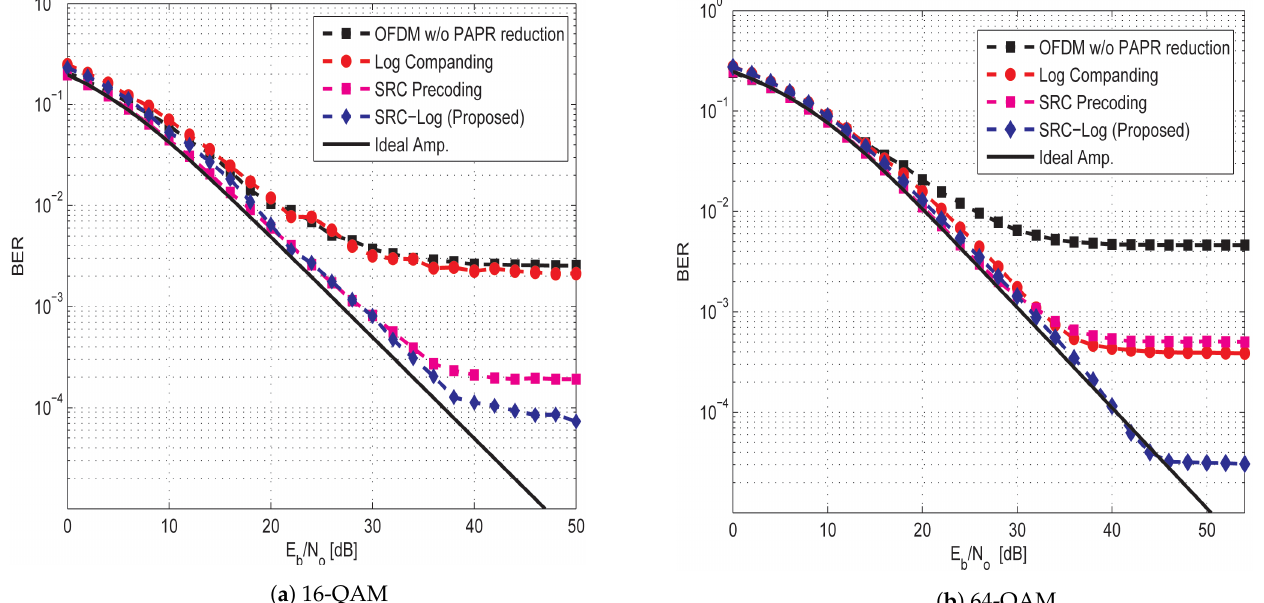
Figure 5. BER performance of SRC-Log in Rayleigh channel in comparison with SRC precoding and Log companding, along with OFDM w/o PAPR reduction. The case of an ideal amplifier is shown in a solid